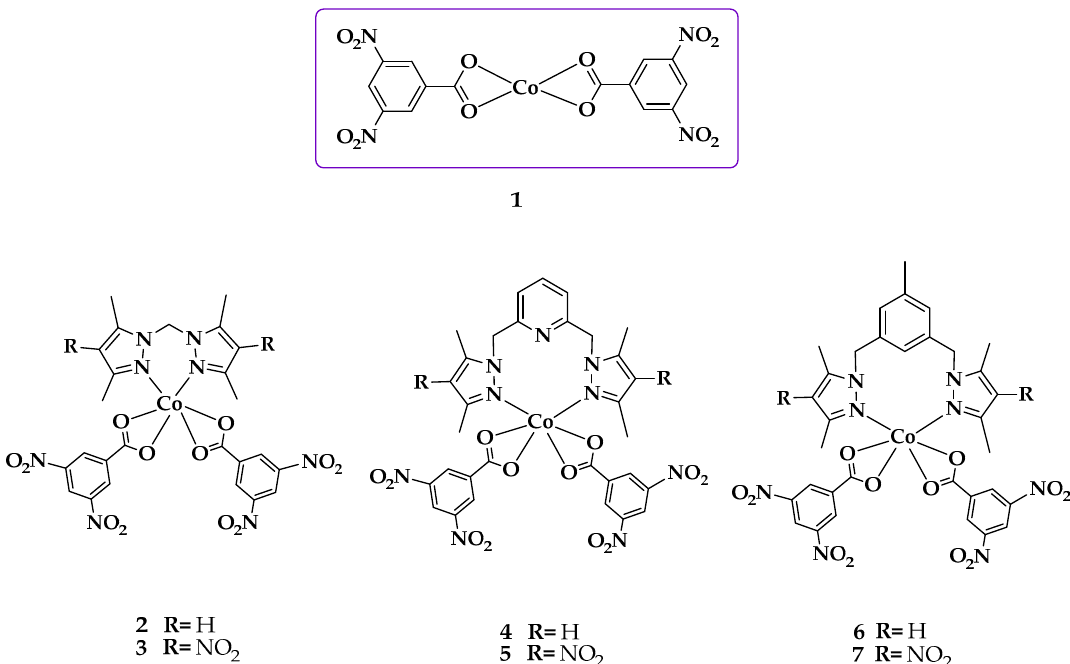
Figure 2. Possible structure of the complexes under study.